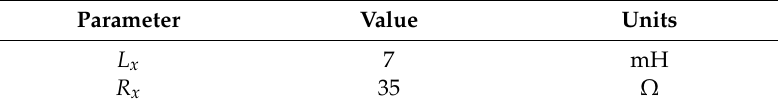
Table 4. Three-phase VSI passive